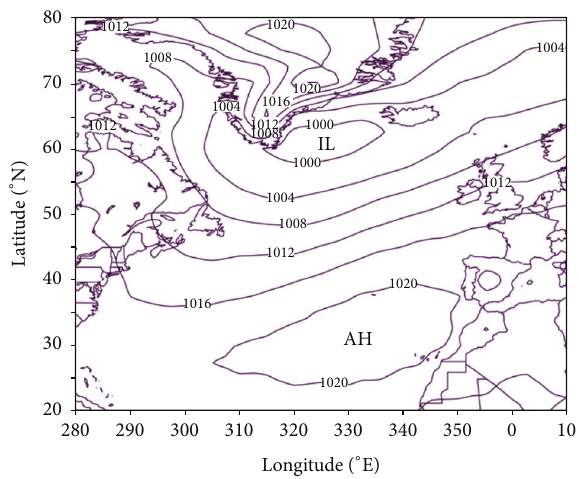
Figure 1: DJF mean SLP over the North Atlantic,